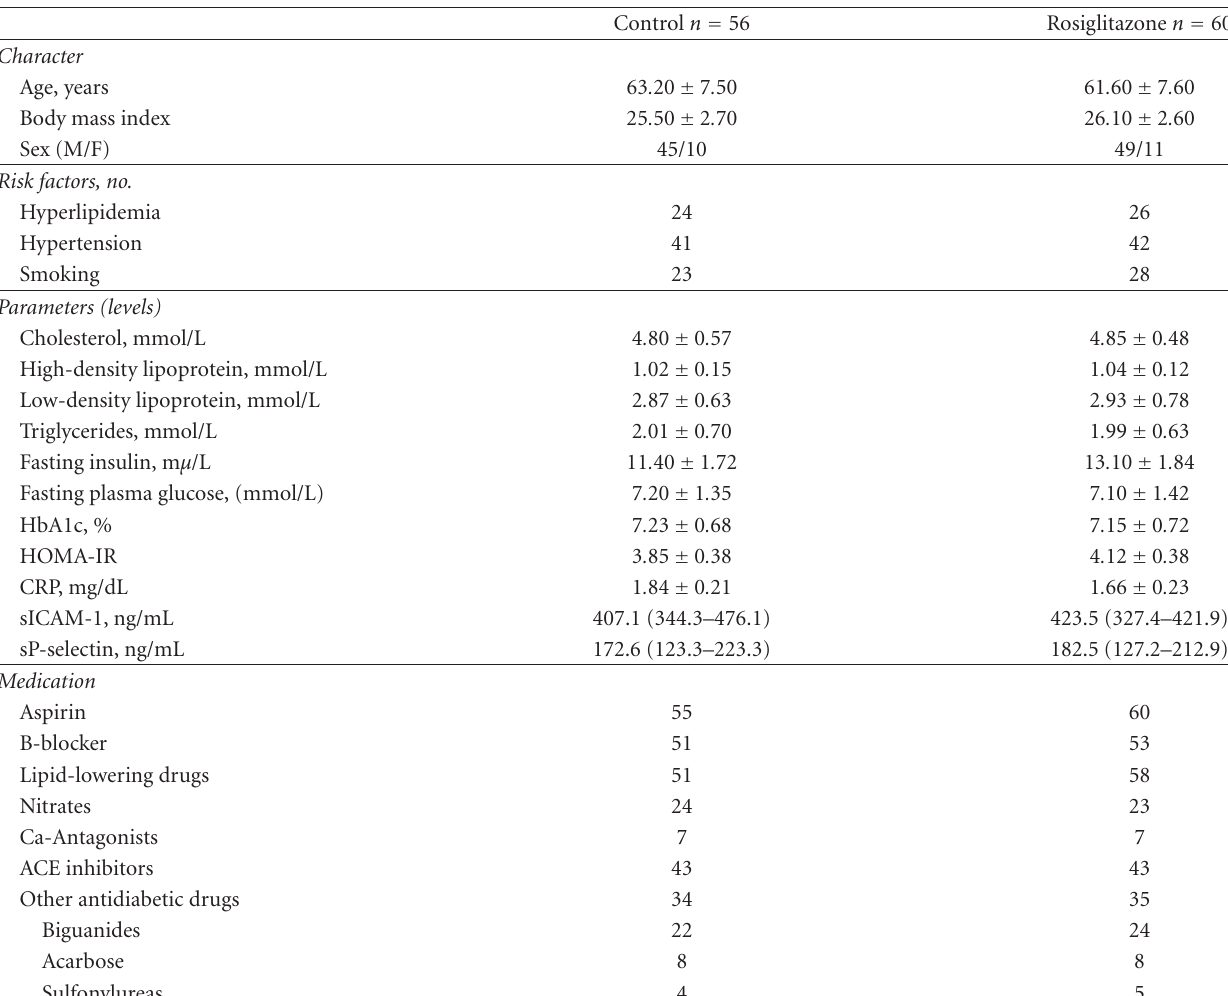
Table 1: Baseline clinical characteristics of patients with diabetes and coronary artery disease after percutaneous coronary intervention.